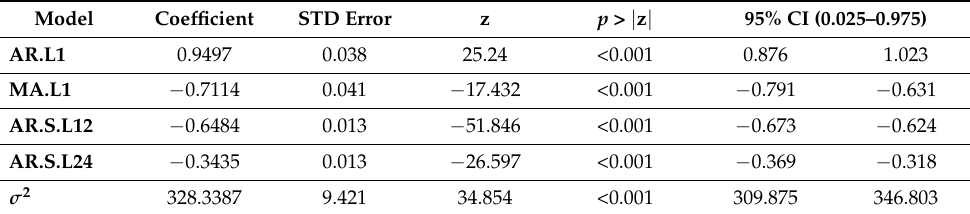
Table 1. Results for the seasonal ARIMA model in this study.